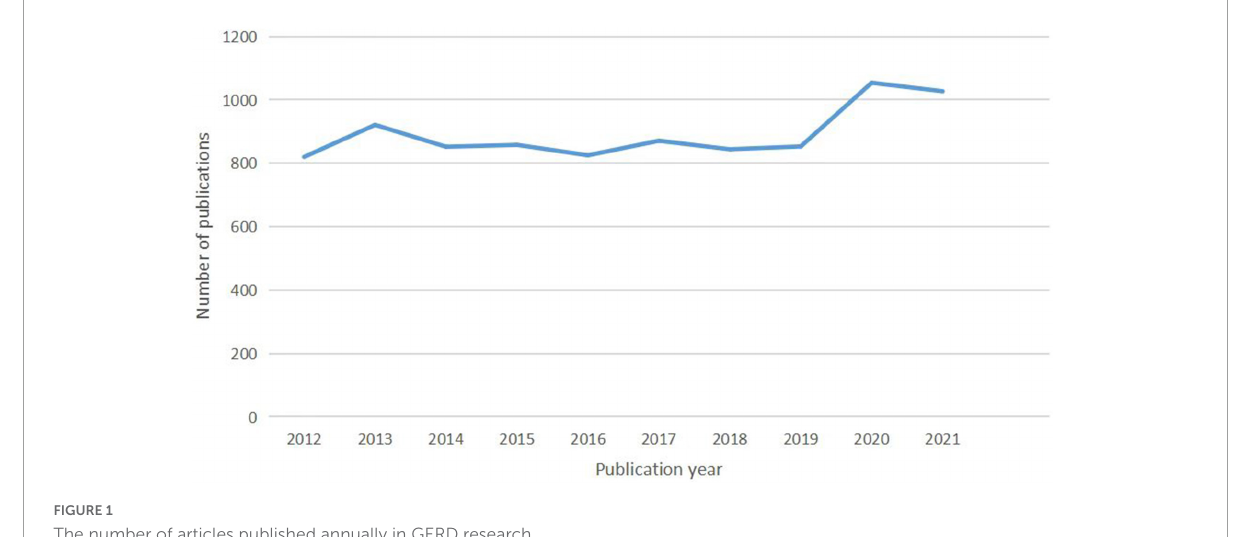
FIGURE1 The number of articles published annually in GERD research.